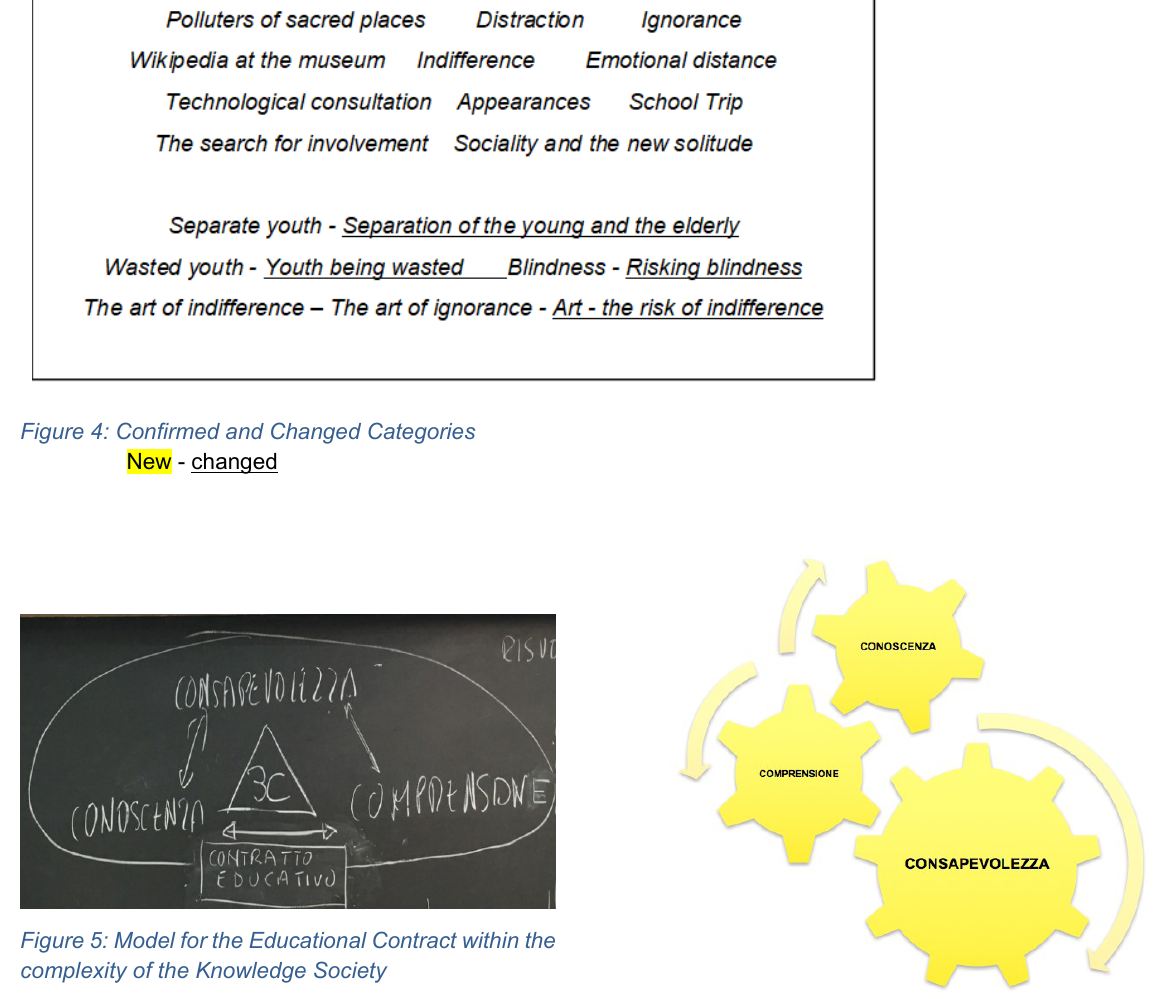
Figure 6: Virtuous Circles developed by the